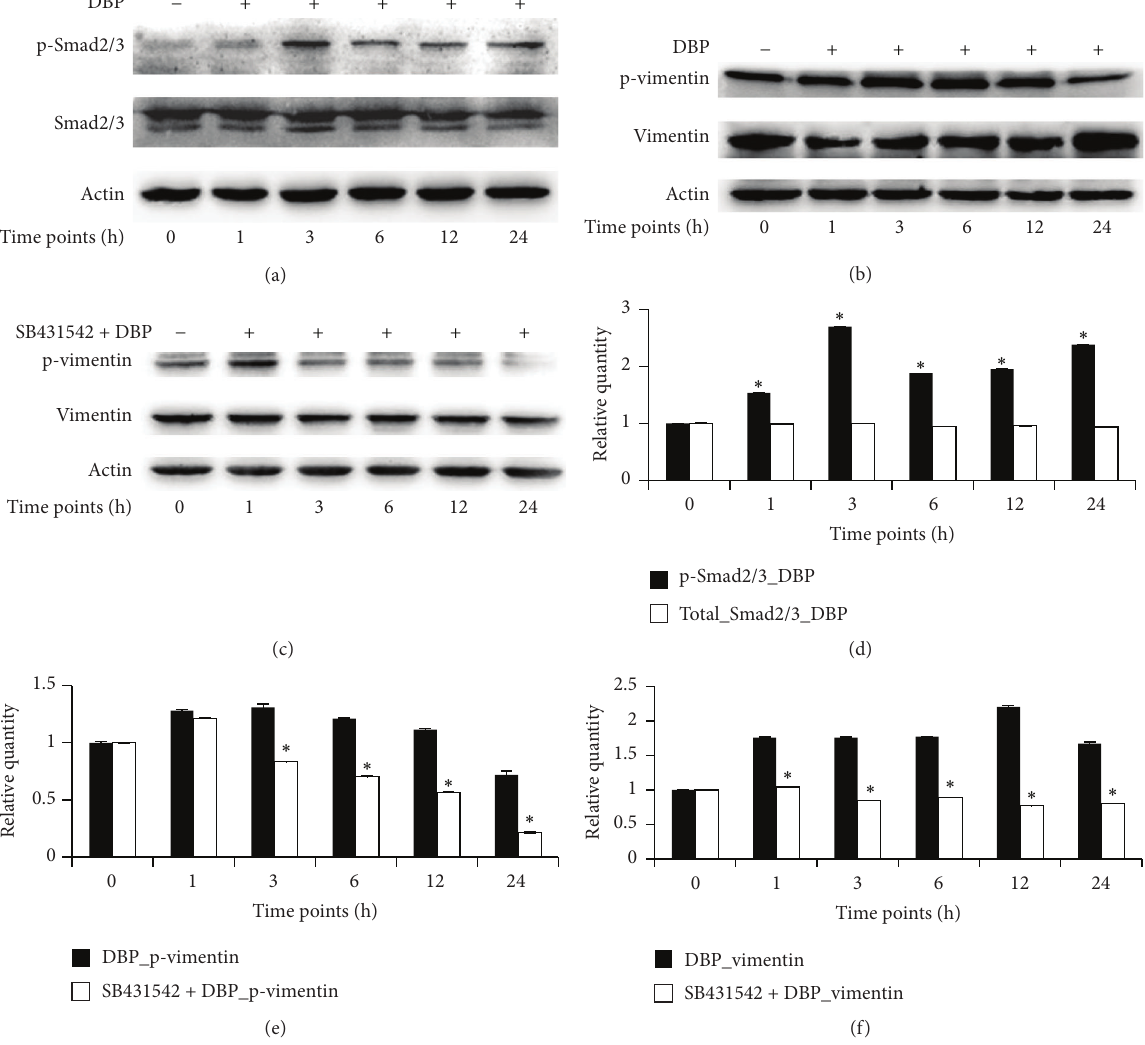
Figure 2: Effects of Smad2/3 on phosphorylation and expression of vimentin in DBP-treated SCs at 0, 1, 3, 6, 12, and 24 h. (a), (b), and (c) show western blotting results of p-Smad2/3, Smad2/3, p-vimentin, vimentin, and actin in DBP- or SB431542 + DBP-treated SCs at different time points. (d), (e), and (f) show the relative quantitative analysis of western blotting results by Image J software. 𝑃 < 0.05 was considered statistically